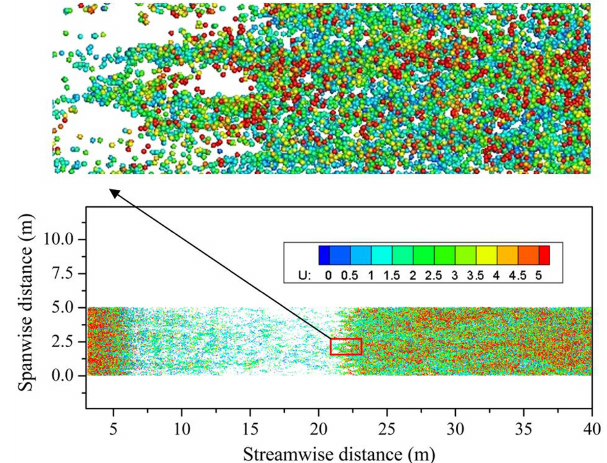
Figure 9. The top view of the particle positions of the wind-blown sand in the presence of SCBs, where U represents the speed of the particles ( u τ = 0 . 6ms − 1 ; N = 5–20m).